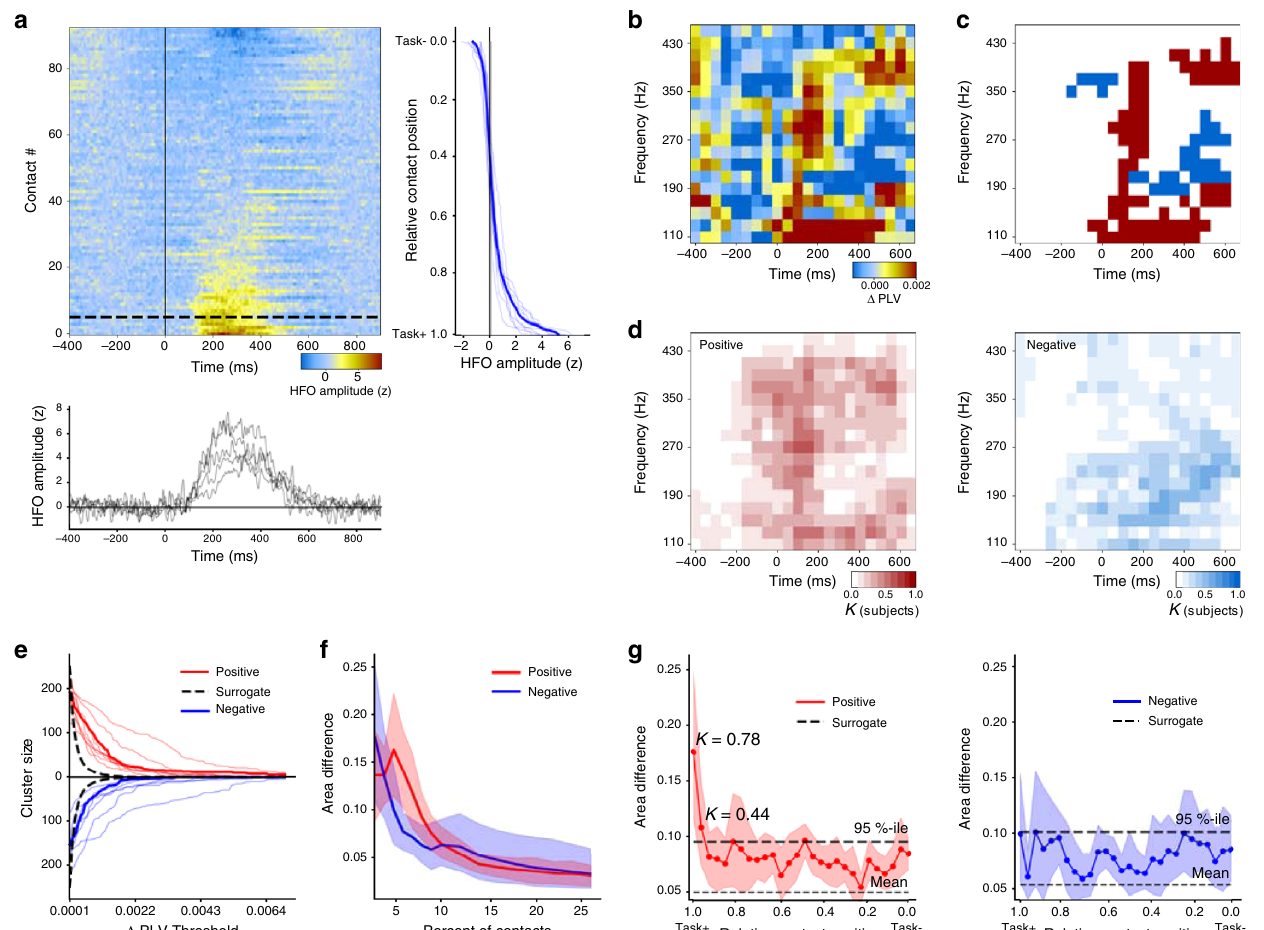
Fig. 8 Transiently enhanced HFO synchrony among task-relevant areas during visuomotor processing. a HFO amplitude is increased above baseline levels in a subset of SEEG electrode contacts (representative subject, contacts sorted by the mean HFO amplitude in 150 – 350 ms time window, frequencies averaged across 110 – 430 Hz, z -score normalized by the pre-stimulus baseline from – 500 ms to – 10 ms). The vertical line plot indicates the mean (thick line) and individual (thin lines) sorted HFO responses for all subjects in the 150 – 350 ms window. The horizontal line plot shows the mean (thick line) and individual (thin lines) temporal evolution of the HFO responses for the top 5% of electrode contacts for all subjects. b Change in PLV from baseline levels among the top 5% of electrode contacts (200 ms time windows for frequencies from 110 to 450 Hz frequencies for the same subject that is shown in a ). c Three largest positive (red) and negative (blue) time-frequency clusters for the representative subject (threshold for PLV change: 0.001). d Superposition of the three largest positive (left) and negative (right) clusters of all subjects ( K indicates the fraction of subjects with a cluster contributing to each time- frequency element). e Sum of the time-frequency elements in the three largest clusters as a function of the clustering threshold for the positive and negative clusters (thick lines, group mean; thin lines, individual subjects; black dashed line indicates 95%-ile of the cluster sizes found with identical analysis of surrogate data). f Difference of total cluster-size areas (area-under curves in e from threshold of 0 to inf) from threshold between the data and surrogate mean for varying fractions of contacts used in synchrony estimation (averaged across subjects, shaded areas indicate bootstrapped 5 and 95 %-ile con fi dence limits of the means). g Cluster-size areas (data minus surrogate as in f ) for synchronization evaluated in 5% contact sets along the Task + … Task – axis de fi ned by sorted HFO amplitudes (black lines indicate the 95%-ile (thick line) and mean (thin line) of surrogate different HFO components in the micro-scale laminar pro fi les (see Fig. 5).